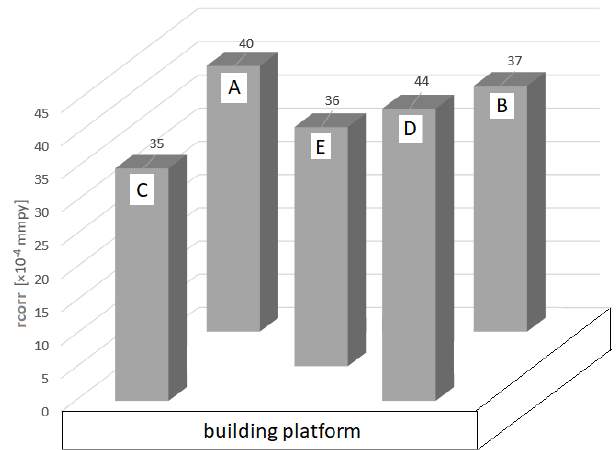
Figure 18. Distribution of corrosion rate in strategic positions on the build platform.